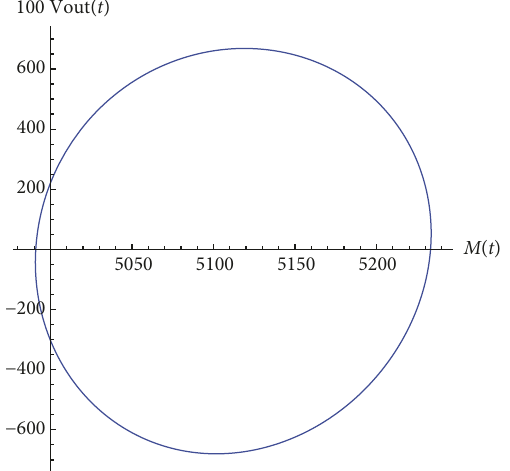
Figure 26: 𝑉 𝑜𝑢𝑡 (𝑡) versus 𝑀(𝑡) of Type A Wien oscillator: fractional memristor with 𝛼 = 0.75 .